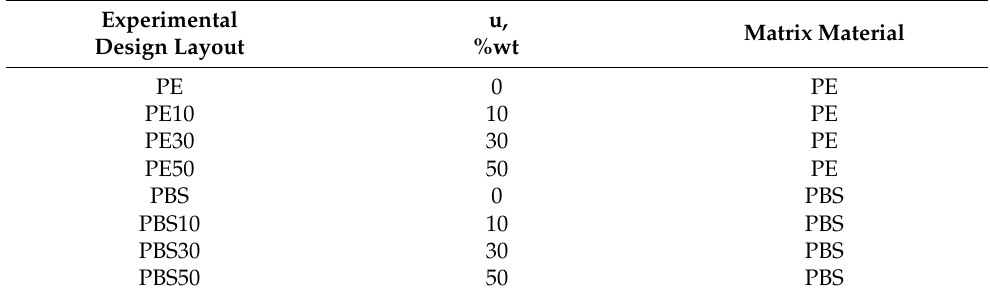
Table 1. Experimental